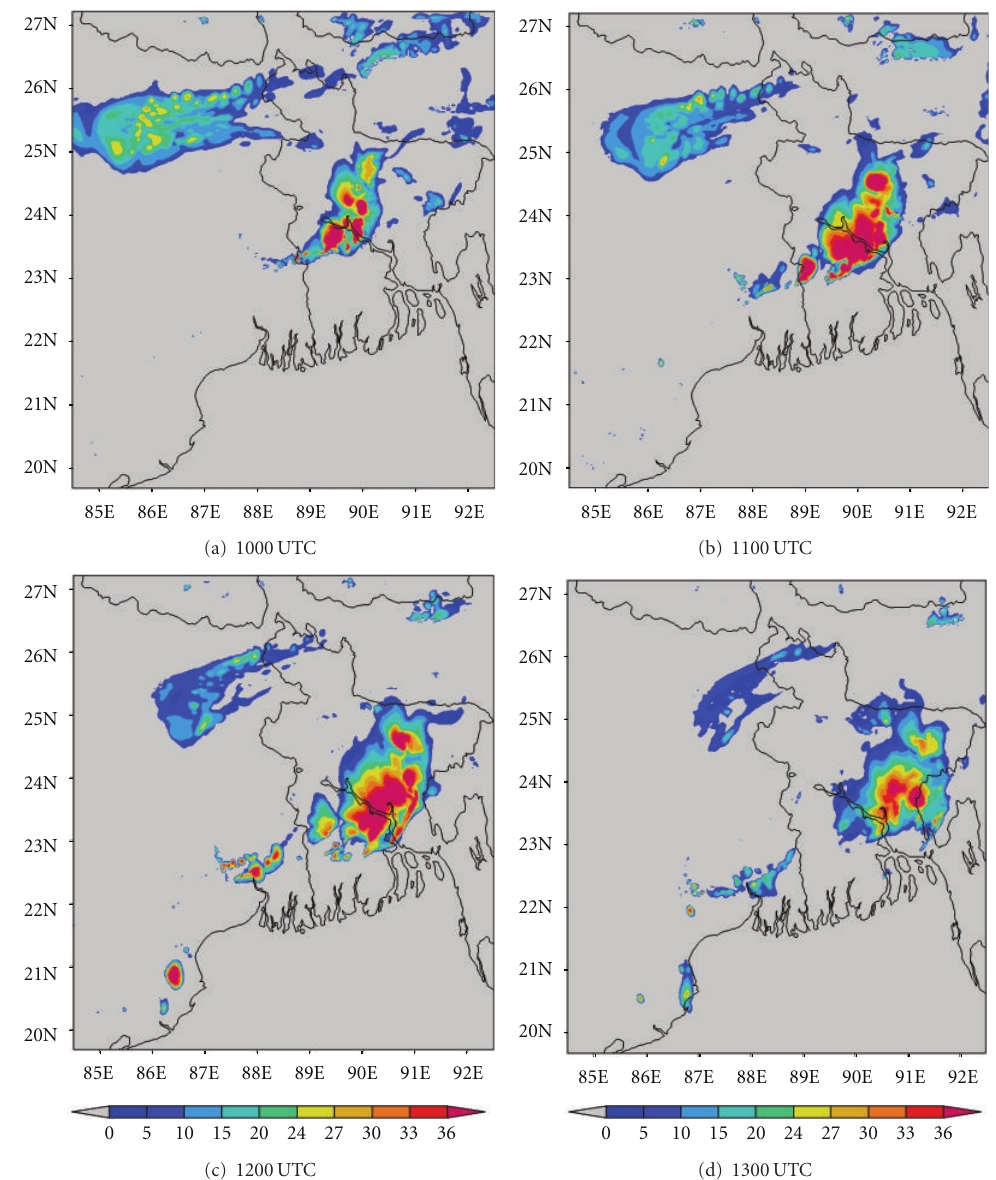
Figure 9: ARW-simulated composite radar reflectivity (dBZ) pictures from 1000 to 1300 UTC on 11, May, 2009.